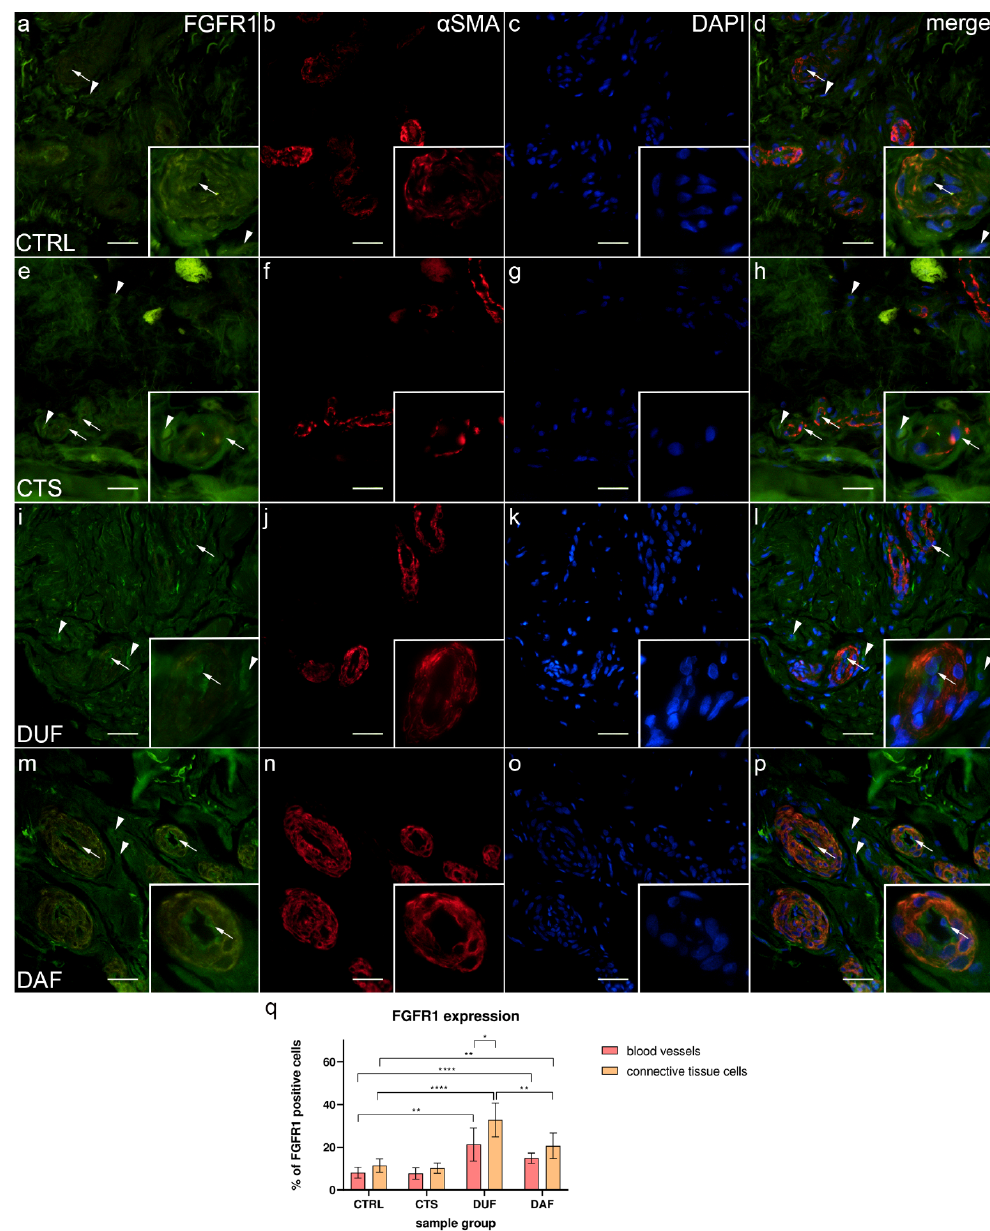
Figure 4. Co-expression of FGFR1 and α -SMA in connective tissues of patients with CTS and DD. CTRL–palmar fascia of CTS patients ( a – d ); RF–flexor retinaculum of CTS patients ( e – h ); DUF–clinically unaffected palmar fascia of DD patients ( i – l ); DAF–clinically affected palmar fascia of DD patients ( m – p ). FGFR1 expression ( a , d , e , h , i , l , m , p ) is seen in blood vessels (arrows) and surrounding connective tissue cells (arrowheads); α -SMA staining shows sections through blood vessels ( b , f , j , n ). DAPI staining displays all cell nuclei ( c , g , k , o ). Insets ( a – p ) reveal the distribution of FGFR1 staining in blood vessels. Double immunofluorescence staining to FGFR1, α -SMA, and DAPI, 400 × magnification, scale bar 100 µ m. The graph displays statistically significant differences in FGFR1 expression of blood vessel and connective tissue cells ( q ). Error bars show standard deviation; * p < 0.05, ** p < 0.01, **** p < 0.001. The expression of FGFR1 in blood vessels of control samples (8.10% ± 2.51%) was significantly lower compared to DUF (21.30% ± 7.70%; p = 0.002; d = 2.304) and DAF samples (14.90% ± 2.42%; p < 0.0001; d = 2.754). Connective tissue cell FGFR1 expression was also significantly lower in control samples (11.40% ± 3.10%) compared to both